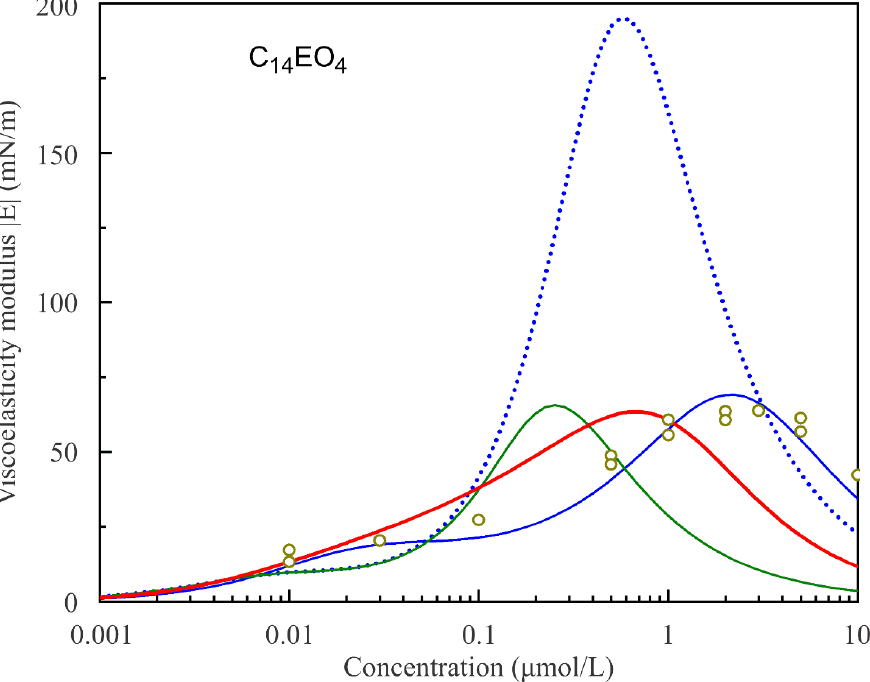
Figure 8. Experimental values of the surface dilational visco-elasticity modulus |E| for C 14 EO 4 solutions of different concentrations measured for the fixed frequency of 0.1 Hz (symbols). Theoretical curves are calculated assuming various numbers of states (blue dotted line for s = 2 and blue solid line for s = 5) with the parameter sets presented in Table 1 and the diffusion coefficient D = 5 ∙ 10 − 9 m 2 /s. Green solid line calculated with parameters listed in Table 1 under s = 2 and D = 1.5 ∙ 10 − 7 m 2 /s. Red solid line corresponds to Model R0, with the parameters used to calculate red solid curve in Figure 1 and D = 2.3 ∙ 10 − 8 m 2 /s. For details see text. The green solid line in Figure 9 was calculated for s = 10 with D = 5 ∙ 10 − 10 m 2 /s. It is seen that the agreement with the experiment is significantly worse than that of the solid orange curve optimised with D = 8.7 ∙ 10 − 9 m 2 /s, but the trend remains the same and the theoretical curve remains rather close to the experimental data. In contrast, for s = 2, the variation of the diffusion coefficient even within a much larger range does not signifi ‐ cantly improve the agreement with the experiment. For example, the violet dotted line in Figure 9, calculated for s = 2 with an unrealistically high D = 2 ∙ 10 − 7 m 2 /s, shows the approx ‐ imately correct maximum value of the visco ‐ elasticity modulus, but is shifted to a more than one order of magnitude smaller concentration. These numerical examples demon ‐ strate once again that the visco ‐ elasticity modulus is much more sensitive to the number of molecular states than to the diffusion coefficient, and that the reorientation models with larger numbers of states reproduce the experimental data much better regardless of the diffusion coefficient.